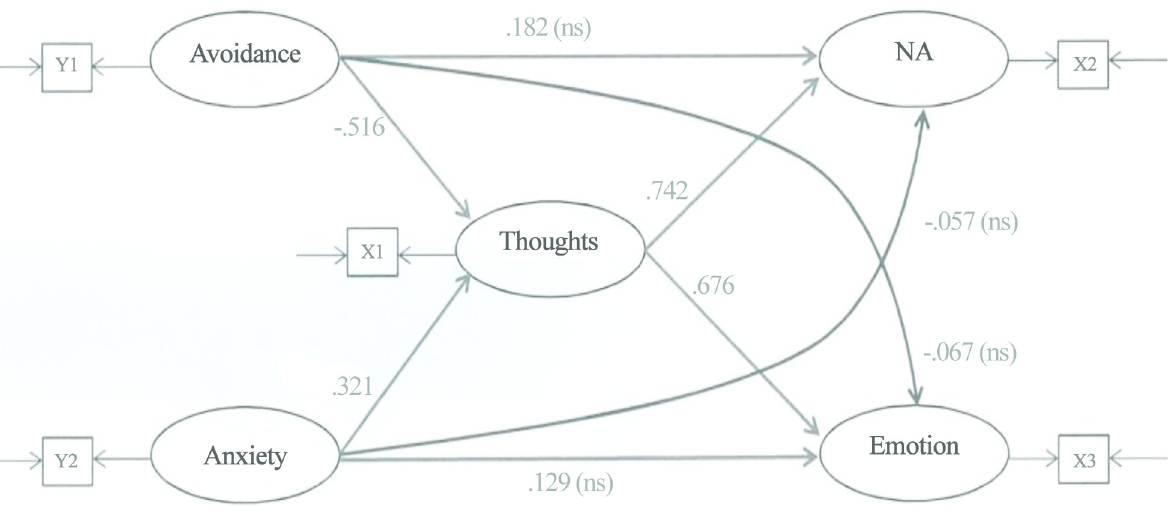
Fig 2. The saturated model (all possible left-to-right pathways). ECR — Avoidant Attachment scale (Y1); ECR — Anxious Attachment scale (Y2); TRIG-Present — Thoughts scale (X1); TRIG-Present — Non-Acceptance scale (X2); TRIG-Present — Emotions scale (X3). doi:10.1371/journal.pone.0133703.g002 Individual participants ’ mean scores for Avoidant Attachment, Anxious Attachment, Thoughts, Emotions, and Non-Acceptance are reported in S1 Fig. Fit statistics for the two models are reported in Table 1. The χ 2 /df, CFI, NNFI, and RMSEA favour the mediator model ( χ 2 /df < 3 [26], CFI > .95 [28], NNFI > .94 [28], and RMSEA = .073 with a 90% confidence interval that includes .05 [26]. The mediator model also has a smaller Model AIC indicating a better fit. In contrast, the SRMR fit both models (SRMR < .1) but favoured the saturated model. The χ 2 difference test,